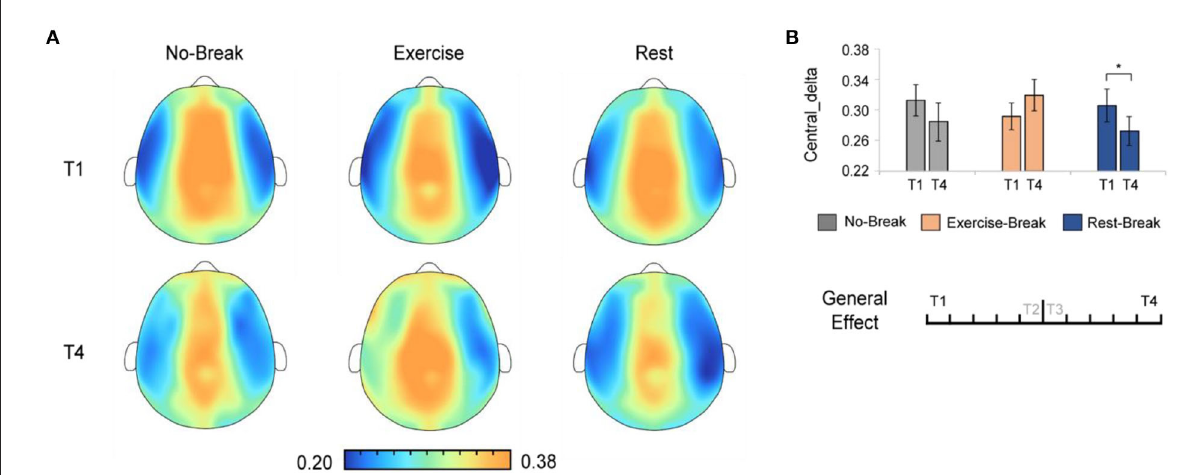
FIGURE6 The delta spectral changes in general effect (T1 vs. T4). (A) The brain topography of the general effect of the mid-task breaks on delta activities. (B) The EEG power ratios of the central delta in the session-start bin (T1) and session-end bin (T4). * p < 0.05. Error bars represent the mean ±